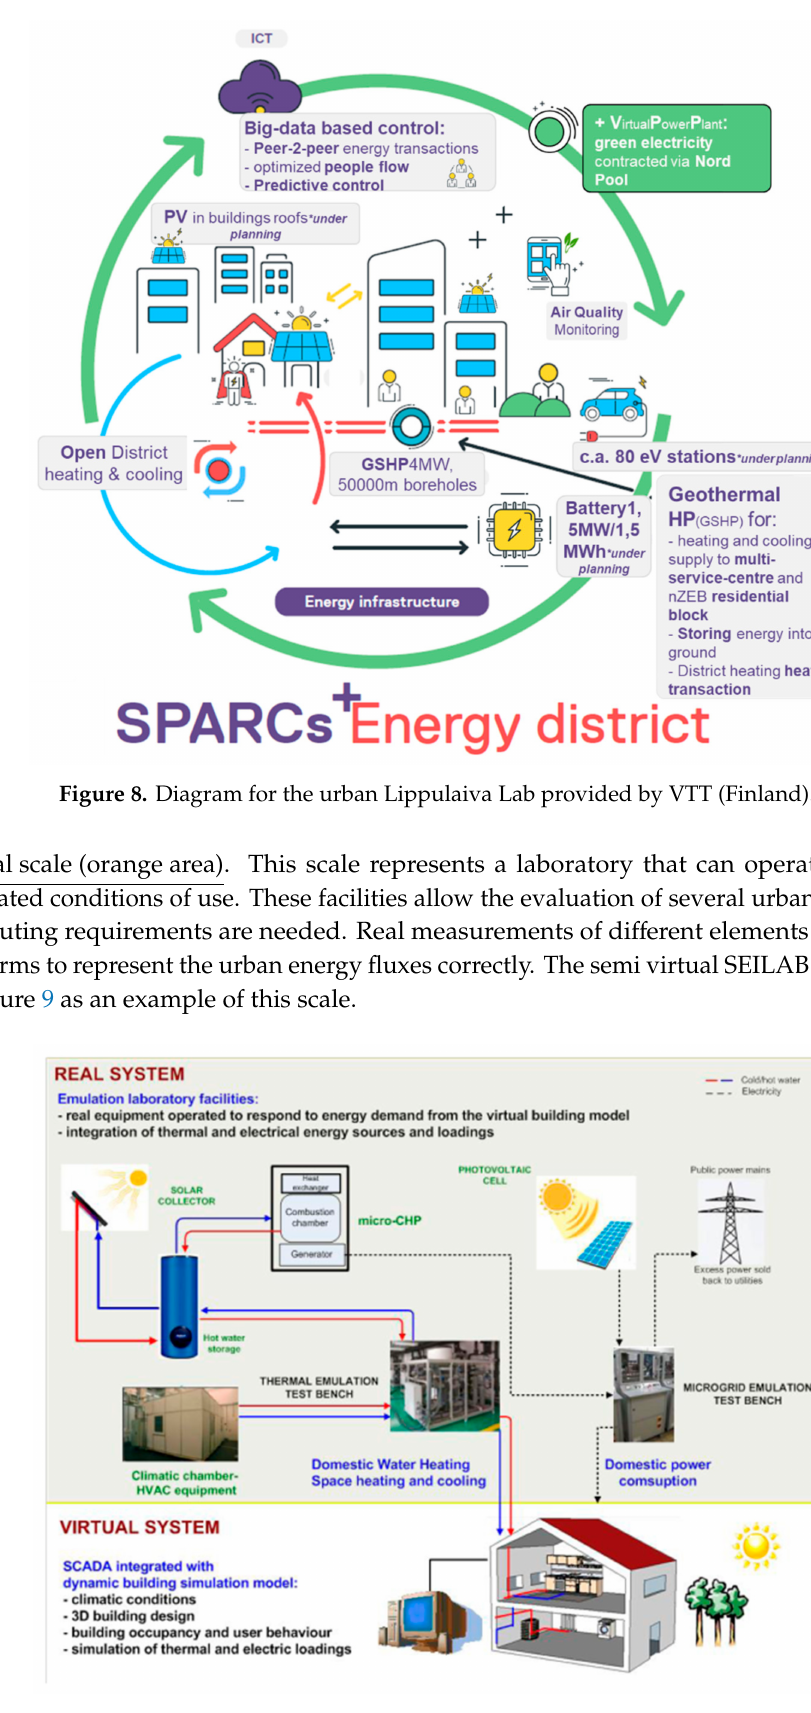
Figure 9. Diagram for the virtual SEILAB facility provided by IREC